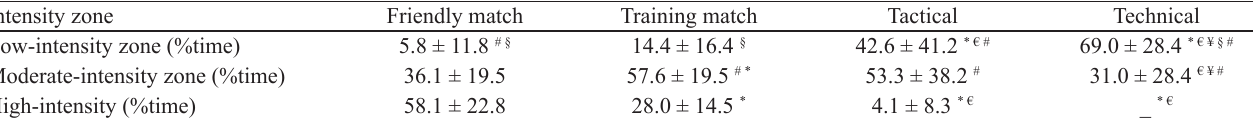
*Difference in comparison to the friendly match, € Difference in comparison to the training match, ¥ Difference in comparison to tactical training; comparisons were made between the same zones. # Difference in comparison to the high-intensity zone, § difference in comparison to the moderate-intensity zone; comparisons were made within the same ( p < .05)